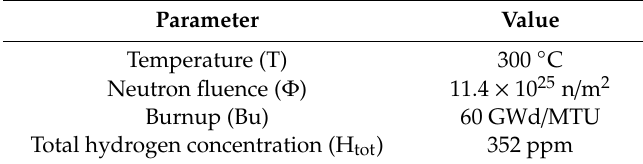
Table 3. Figure 2 is the generated true stress-strain curve of the reference SNF cladding. It is noted that this model does not predict the failure of cladding and can be applied only to the cladding with circumferential hydrides. The strain failure limit of HBF cladding ranges between 1% and 4% [25], and 1% is chosen in this work to be on the conservative side. Table 2. Input parameters for the calculation of mechanical properties of irradiated cladding [24].